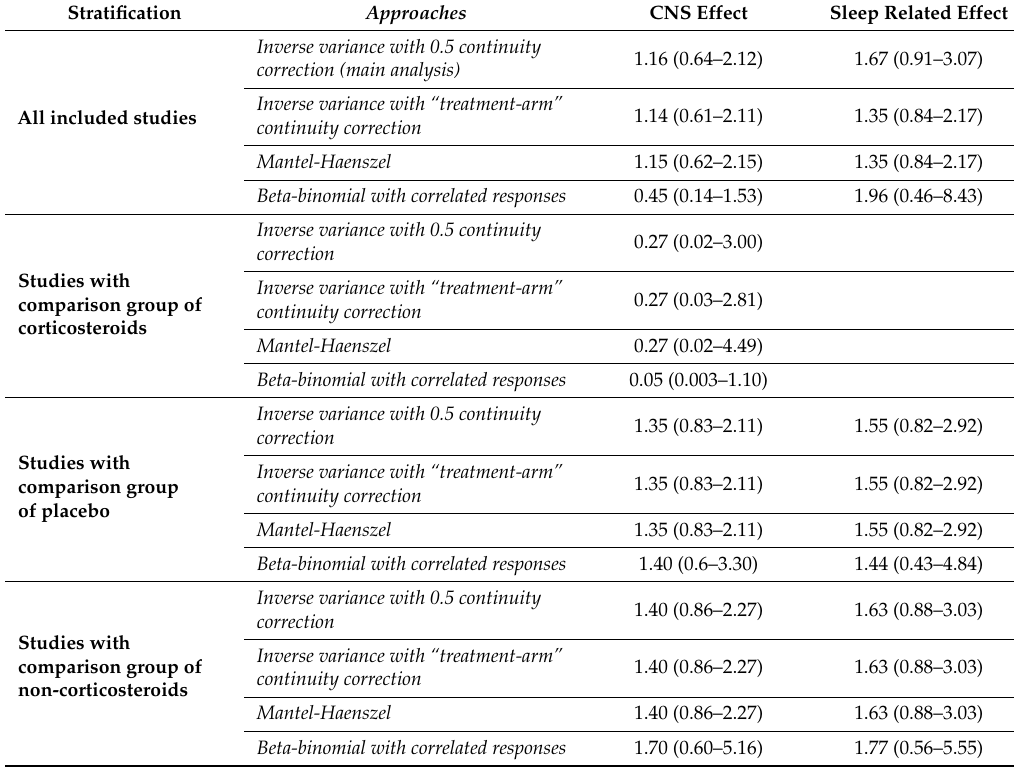
Table A2. Pooled risk ratios in the main and sensitivity analyses.